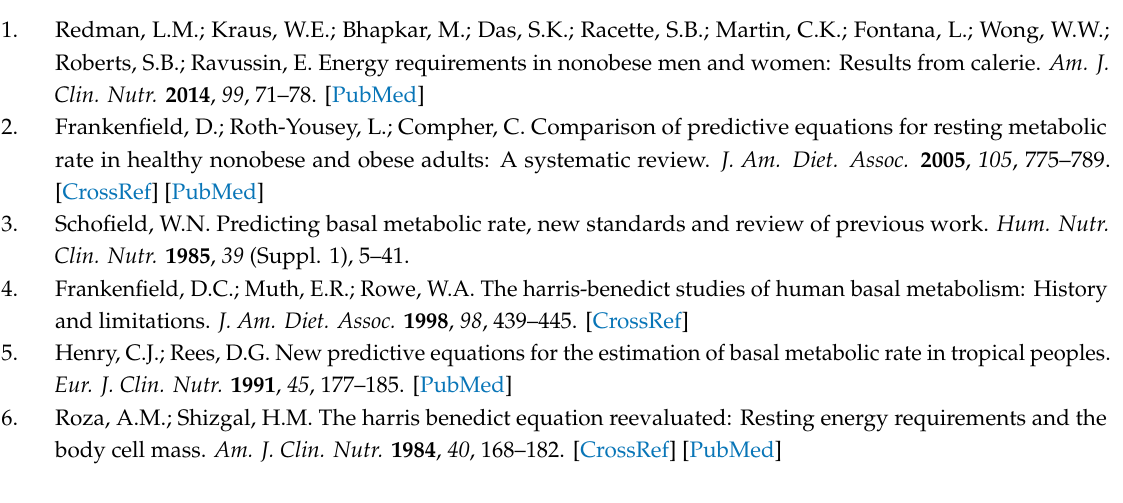
Table S1: Predictive equations for resting energy expenditure (REE) in adults. Figure S1: Bland–Altman plots displaying the agreement between measured and predicted REE in percentage by the equations of (A) Mi ffl in, Figure S2: Bland–Altman plots displaying the agreement between measured and predicted REE in percentage by the equations of (A) Lazzer, (B) Kleiber, (C) Korth, (D) FAO WT, (E) De Lorenzo, (F) Weijs, (G) Bernstein, and (H) De Luis; Figure S3: Bland–Altman plots displaying the agreement between measured and predicted REE in percentage by the equations of (A) Henry and Rees (tropical populations), (B) Henry WTHT, (C) Harris-Benedict 1984, and (D) Harris-Benedict 1919, Figure S4: Bland–Altman plots displaying the agreement between measured and predicted REE by the body composition-based equations of (A) Muller, (B) Johnstone, (C) Korth, (D) Lazzer 2010, (E) Owen, and (F)